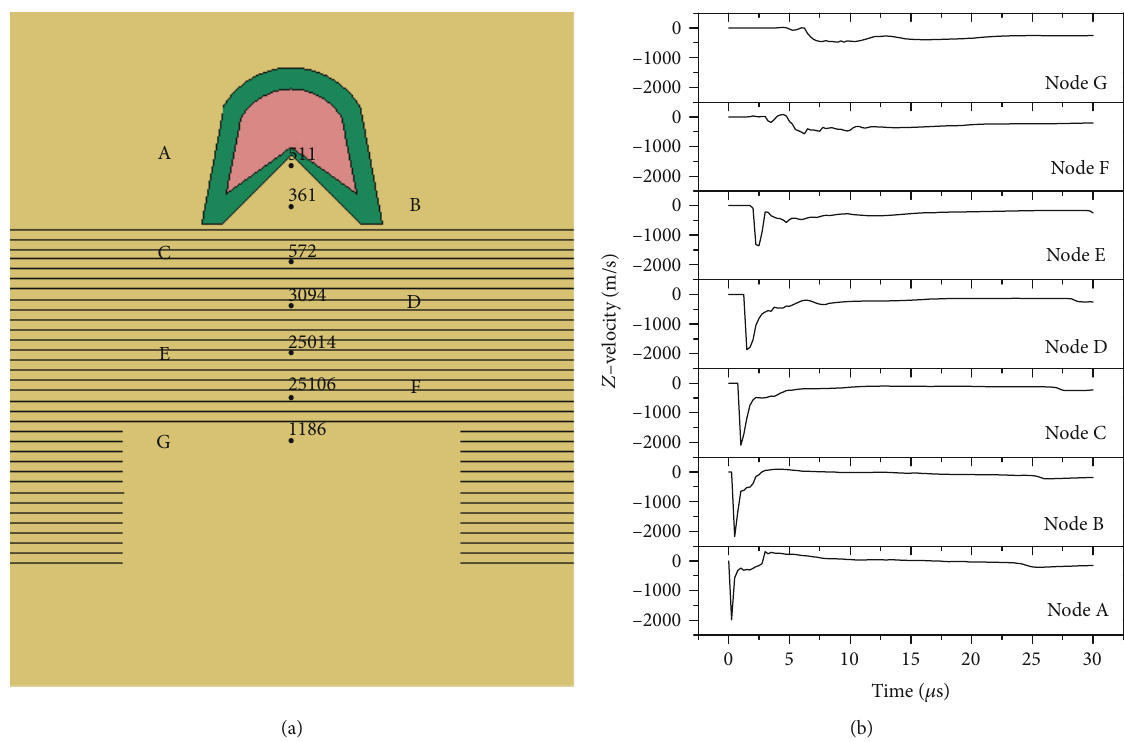
Figure 11: Jet velocity. (a) Location of the velocity observation nodes. (b) Velocity curves of observation